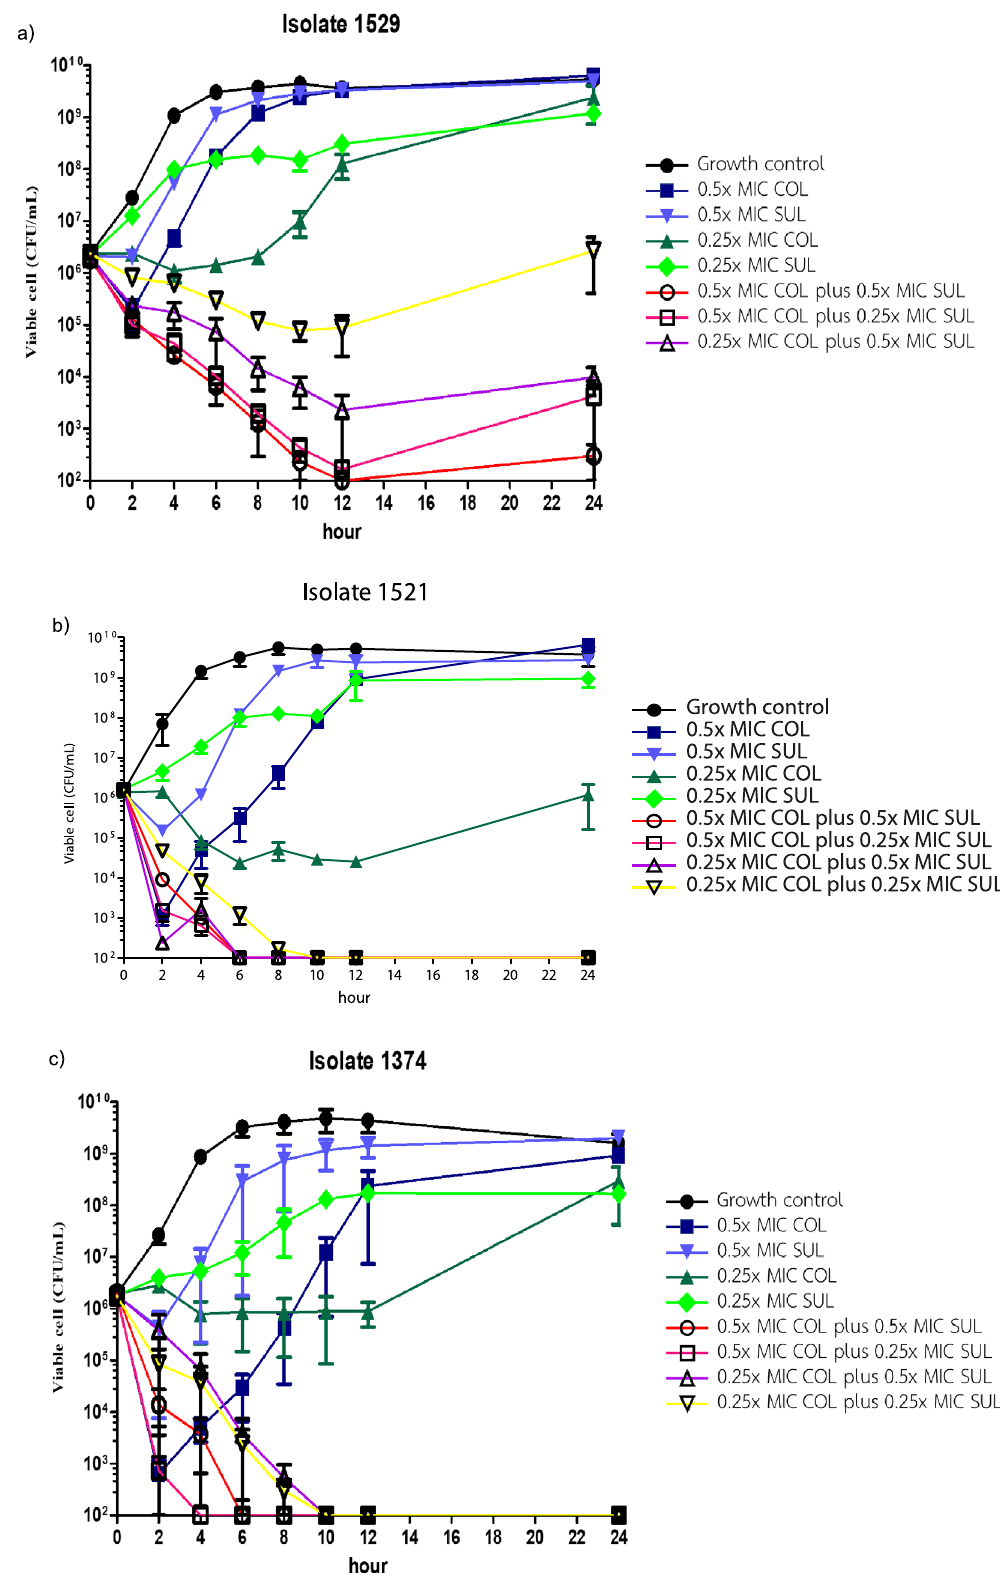
Figure 3. in vitro time-kill study colistin-resistant A. baumannii isolates ( a ) 1529, ( b ) 1521, ( c )